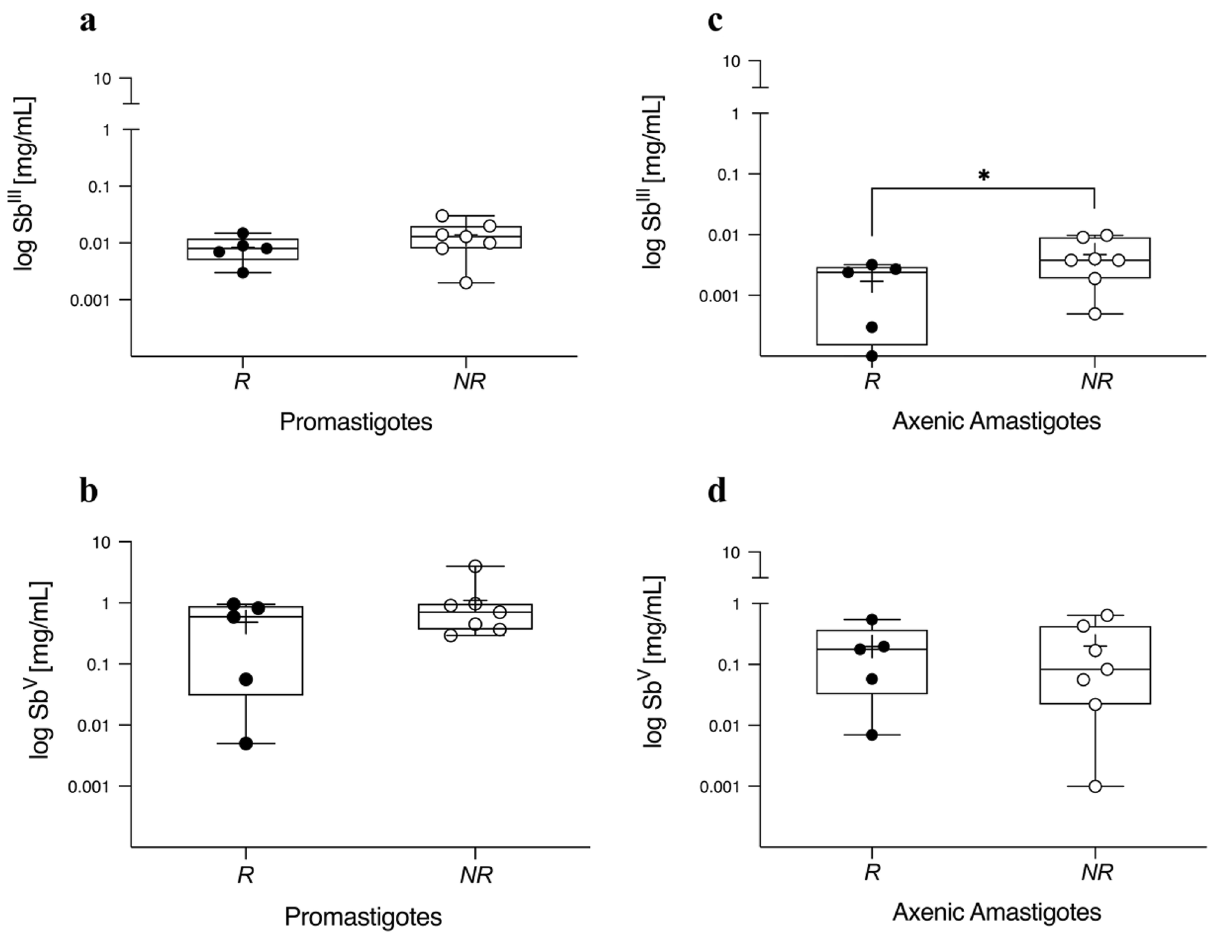
Figure 1. Promastigotes and axenic amastigotes in vitro susceptibility profile to antimony. Both parasite forms of each isolate (n = 12), 4 × 10 6 promastigotes/well and 5 × 10 5 axenic amastigotes/well were exposed to serial dilutions of trivalent (Sb III ) and pentavalent (Sb V ) antimonial for 48 h and 24 h in 96-well plates, respectively. The half-maximal inhibitory concentration (IC 50 [mg/mL]) of parasites viability was measured using a fluorescence method with AlamarBlue reagent. Parasites isolated before treatment of patients with ATL cured after antimonial therapy (R: Responder, filled circle) or with poor clinical response to therapy, either therapeutic failure or relapse (NR: Non-responder, open circle). The data is presented by boxplot diagrams as the mean of three biological replicates for each isolate. Asterisks indicate statistically significant differences: * p = 0.04. The figure was generated using GraphPad Prism version